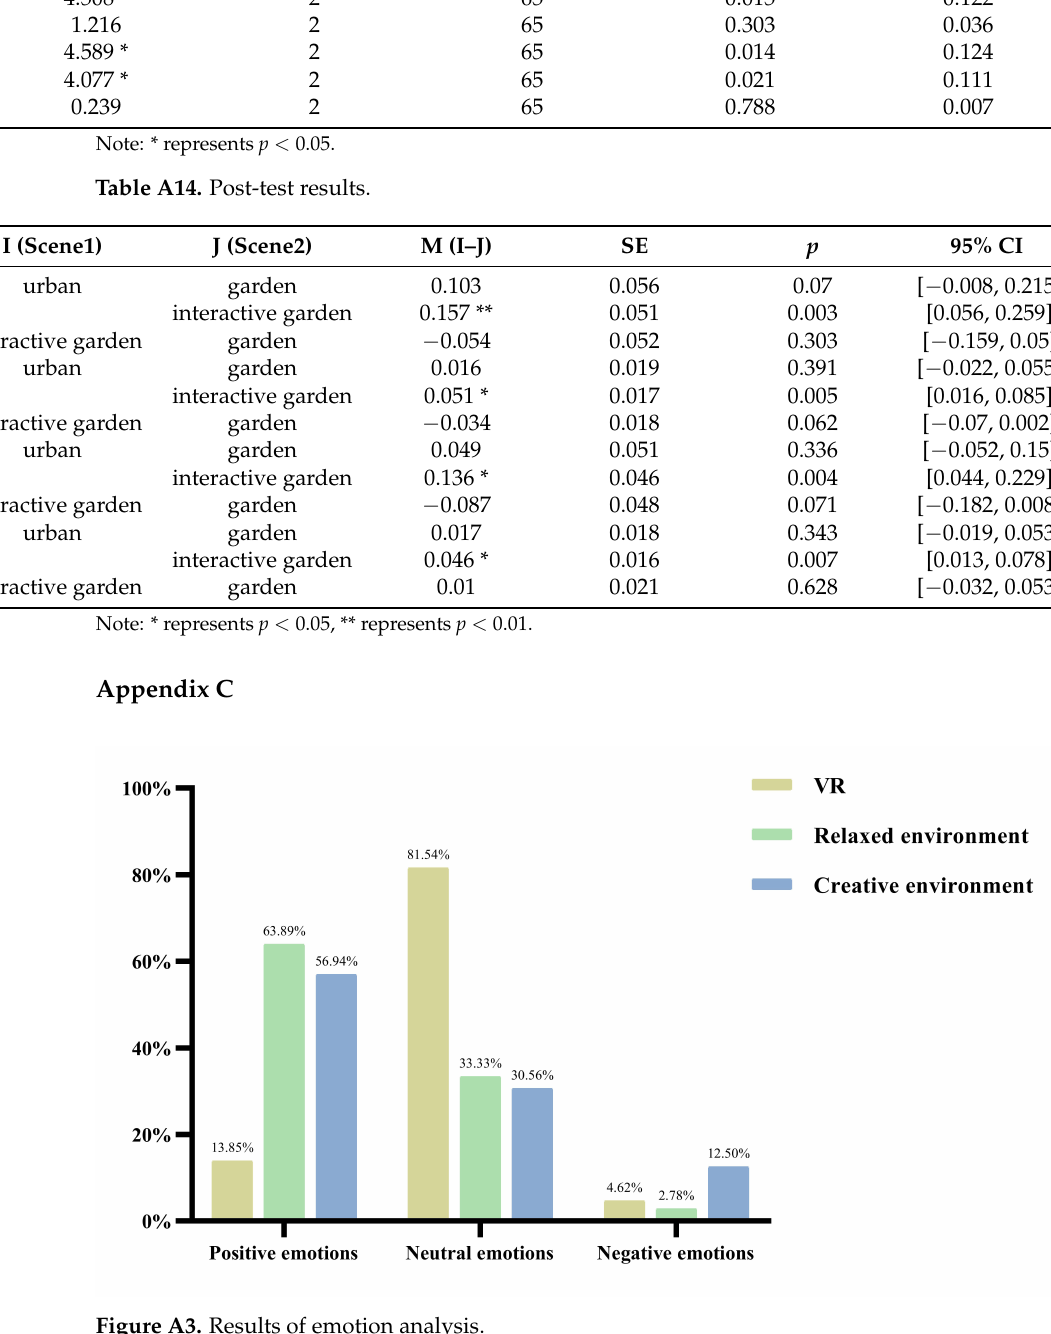
Figure A3. Results of emotion